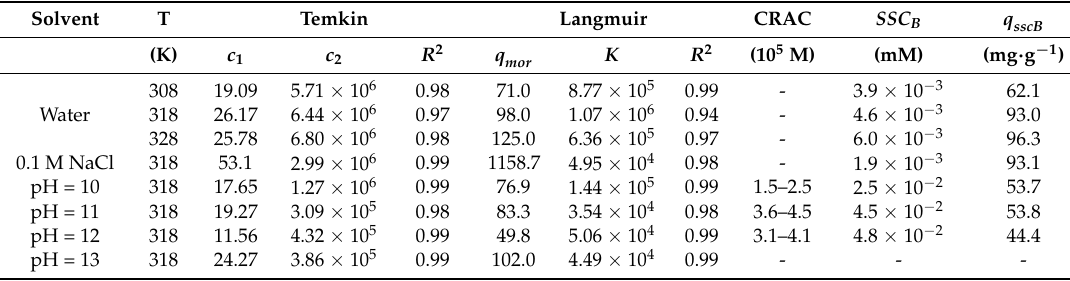
Table 2. The SSC B and q sscB values and parameters that were obtained from the Temkin and Langmuir equations for the adsorption of CR on GO/PAMAM in water, 0.1 M NaCl, and alkaline solutions in section IIA at 308–328